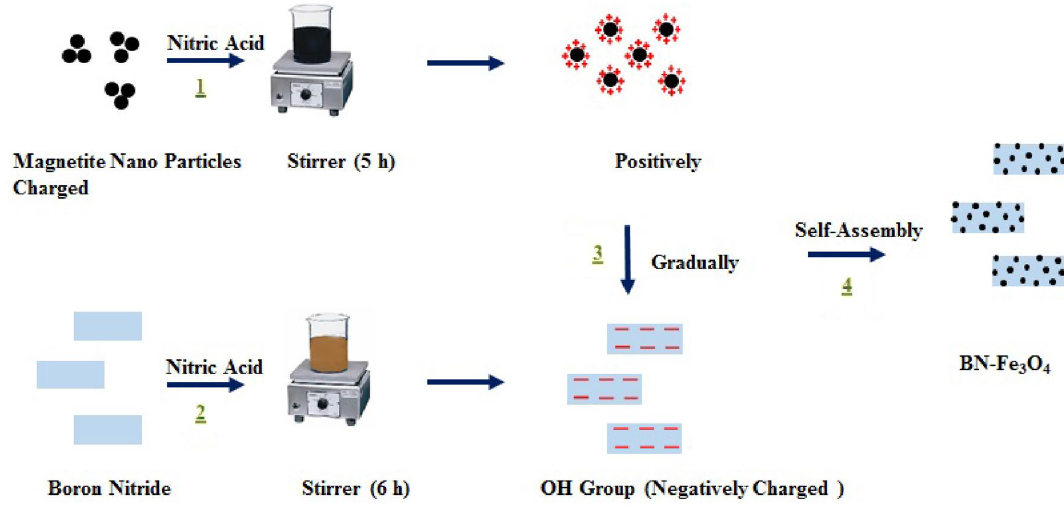
Figure 1. The schematic process of assembly of nanostructured BN–Fe 3 O 4